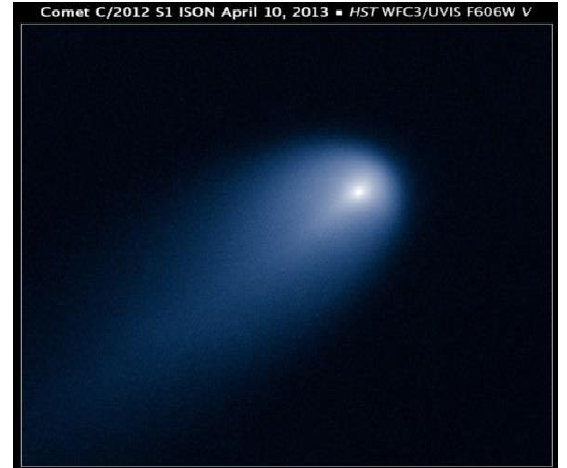
Fig.1: The image of comet C/2012 ISON.